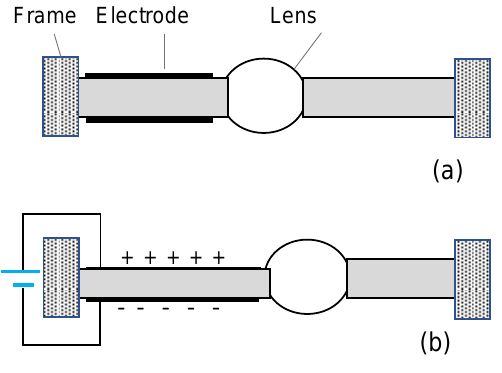
Figure 5. Structure and operation method for a DEA film to shift a solid lens in the transverse direction: ( a ) without voltage and ( b ) with voltage.